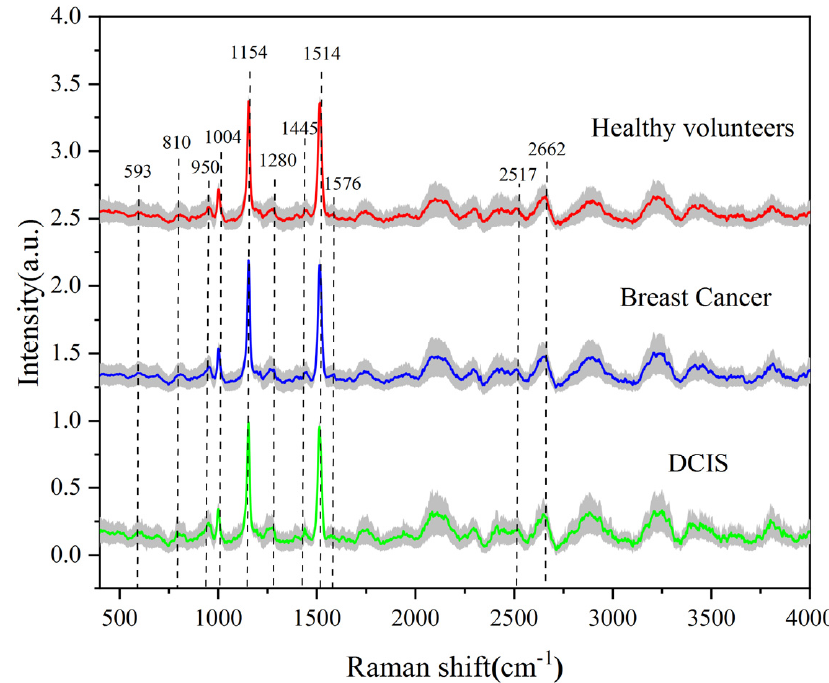
Figure 3. Comparison of normalized mean Raman spectra of serum sample for three groups: (1) Healthy volunteers (n = 241), (2) Breast cancer patients (n = 463) and (3) DCIS patients (n = 100). The shaded area is the standard deviation of the spectra.